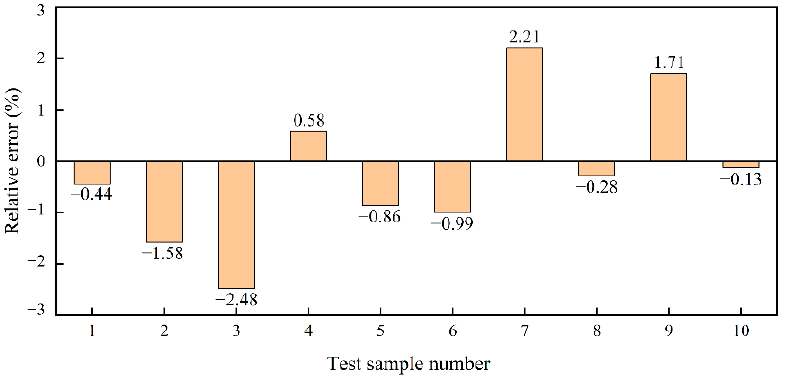
Figure 12. Relative errors between predicted and measured results.